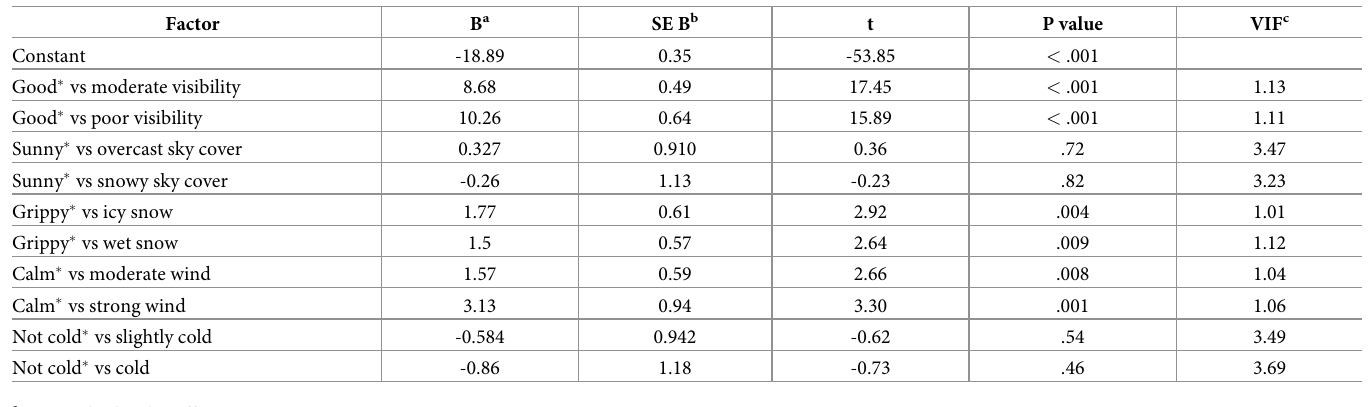
Table 4. Results of the multiple linear regression analysis of environmental factors affecting the EE. Factor B